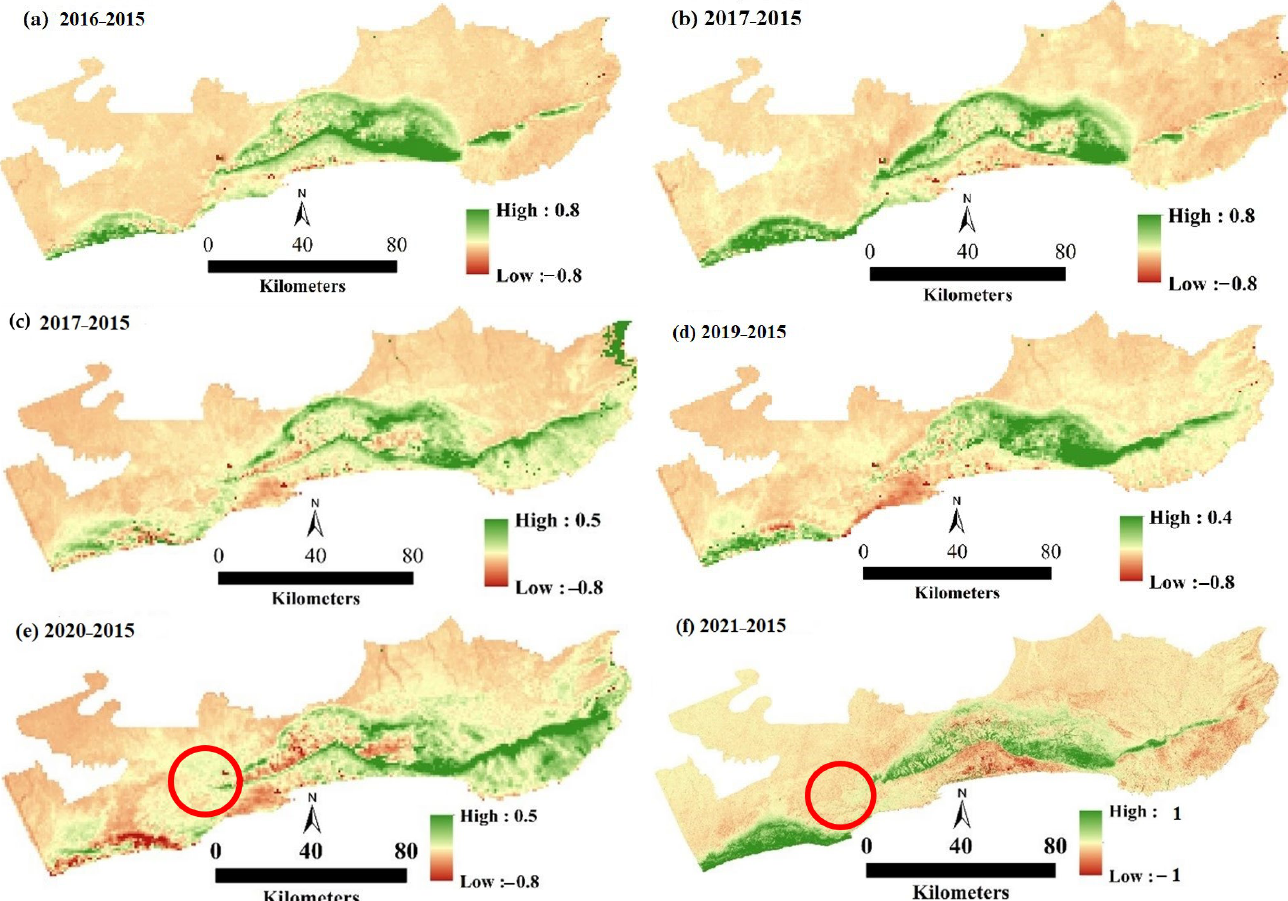
Figure 6. The difference in mean NDVI values in the month of October over Dhofar: ( a ) 2016–2015,